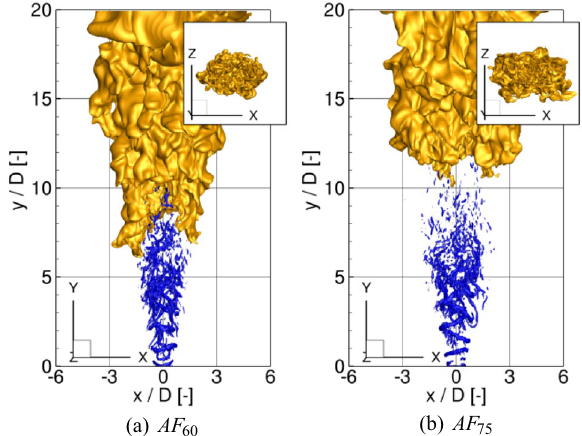
Figure 3. As in Fig. 2 but for AF 60 and AF 75 .